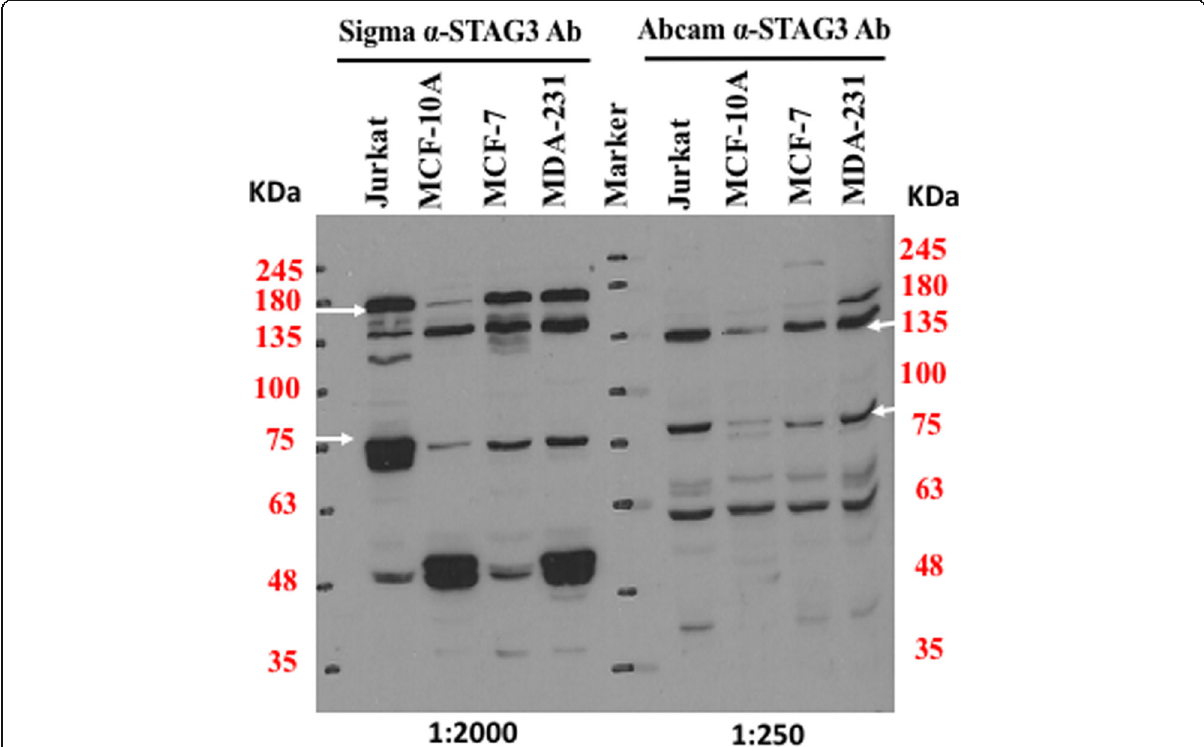
Fig. 2 Using Abcam and Sigma anti-STAG3 antibodies for detecting STAG3 protein levels in different cell lines. Following protein lysates extraction from the normal and cancer cell lines, they were run on the same SDS-PAGE gel with the protein size marker loaded in the middle of the gel. Jurkat cells were the positive control and the normal MCF-10A was the negative control. After transfer to a nitrocellulose membrane, it was cut into two pieces from the region of the protein marker. Each part of the membrane was incubated with either Abcam (diluted 1:250) or Sigma (1:2000 dilution) anti-STAG3 antibody